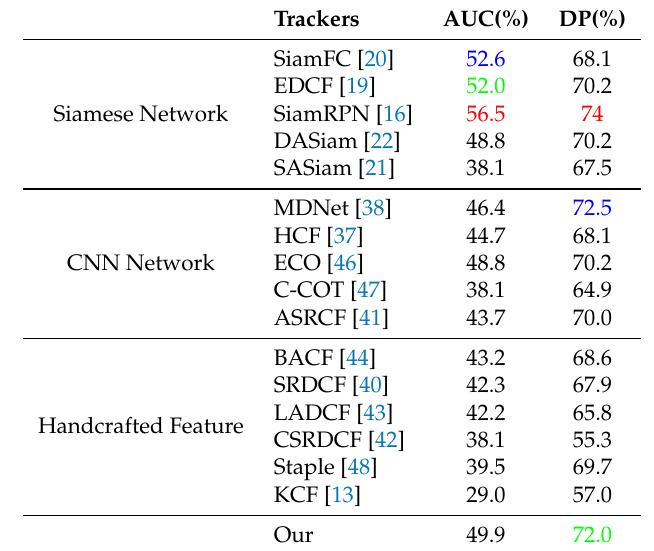
Figure 5. Distance precision and overlap success plots on the UAVDT [7] dataset. These are quantitative results on the 50 benchmark sequences using OPE [45]. The legend of distance precision contains threshold scores at 20 pixels, while the legend of overlap success contains area-under-the-curve scores for each tracker. The proposed algorithm performs favorably against state-of-the art trackers. Table 1. The comparison results of our method and neural network-based trackers in the UAVDT [7], where AUC and DP were used as evaluation criteria. The red, blue, and green colors represent the first, second, and third